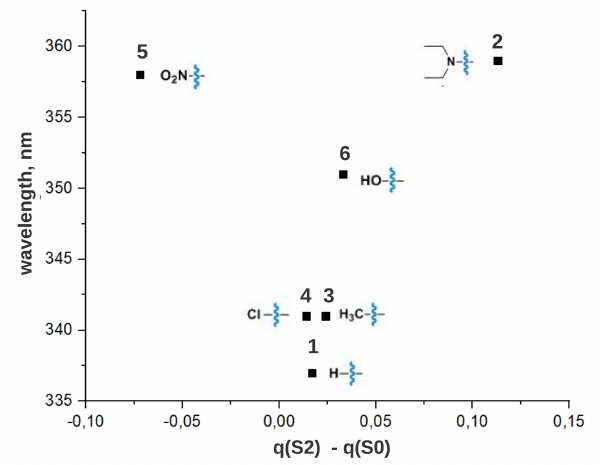
Figure 8. The dependence of λ Z max ( π , π ∗ ) on the charge value relocated from/to a substituent after excitation in the considered